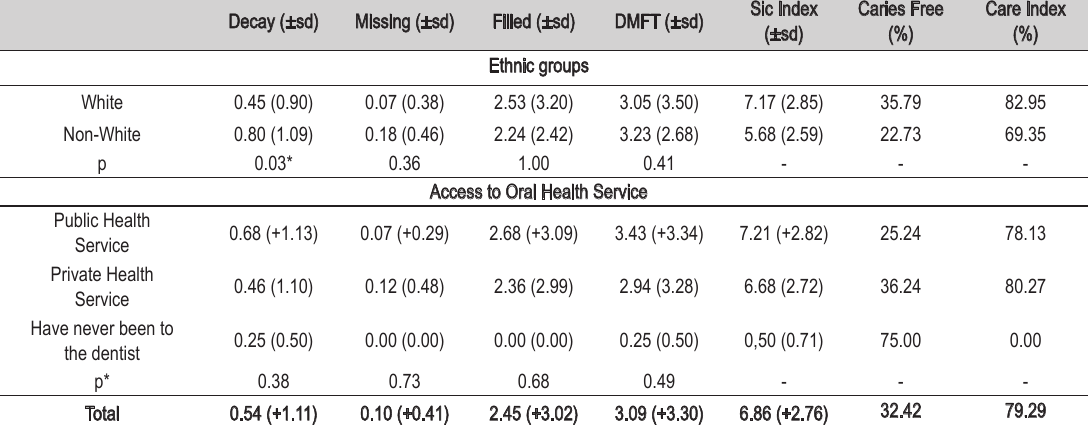
Table 2 - Dental caries and components according to gender, ethnic groups and type of assistance, Agudos, SP, 2012. Decay